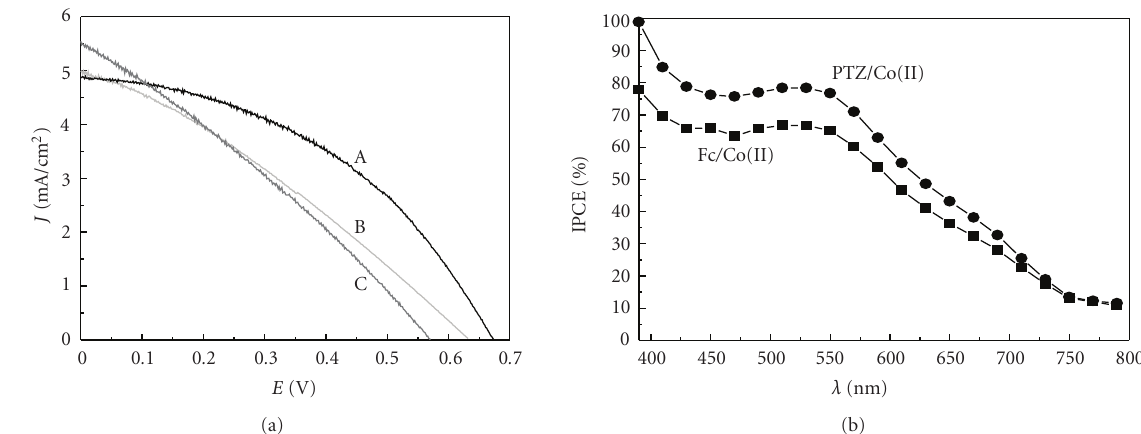
Figure 14: (a) J-V curves obtained in the presence of Co(II)/PTZ (A), I − spectra. Incident irradiance ≈ 0.1 W/cm 2 .